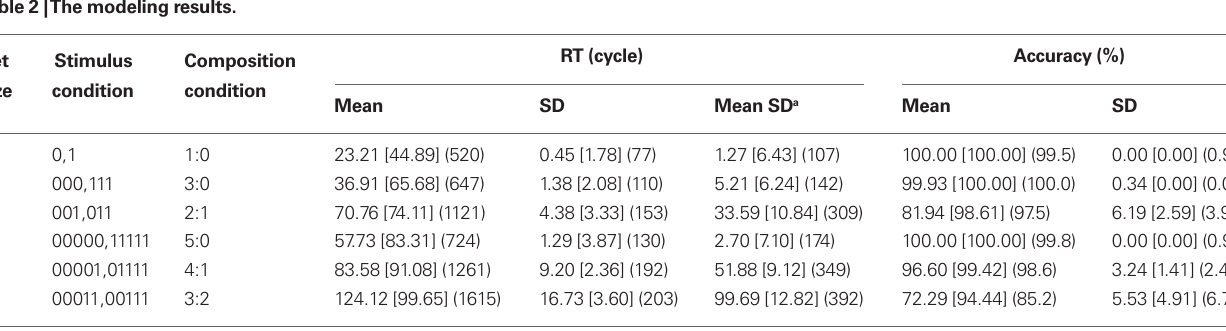
Table 2 | The modeling results.